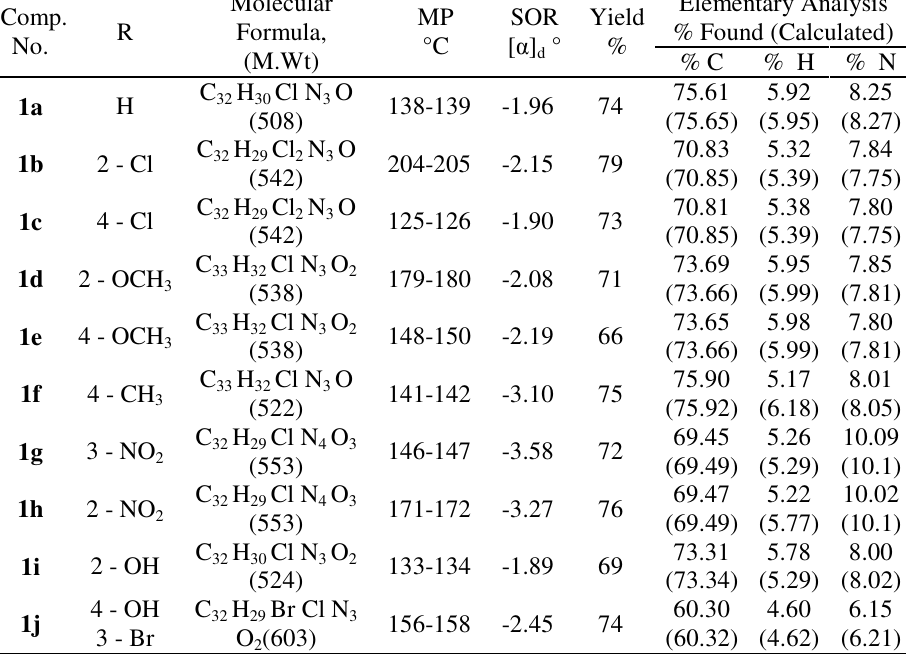
Table 1. Characterization data of compounds